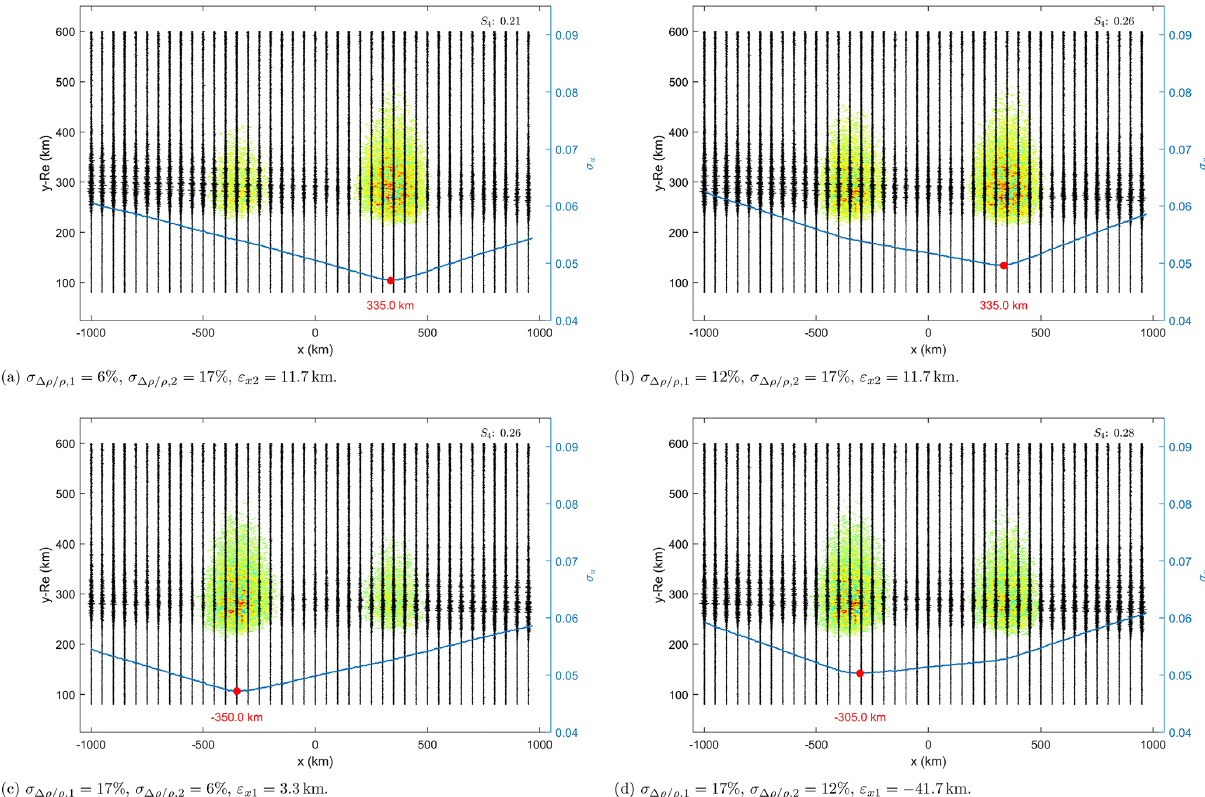
Figure 13. Bubbles at x ref = ± 346 . 7km with weaker rms fluctuation levels on the inbound (a, b) and the outbound bubble (c, d)